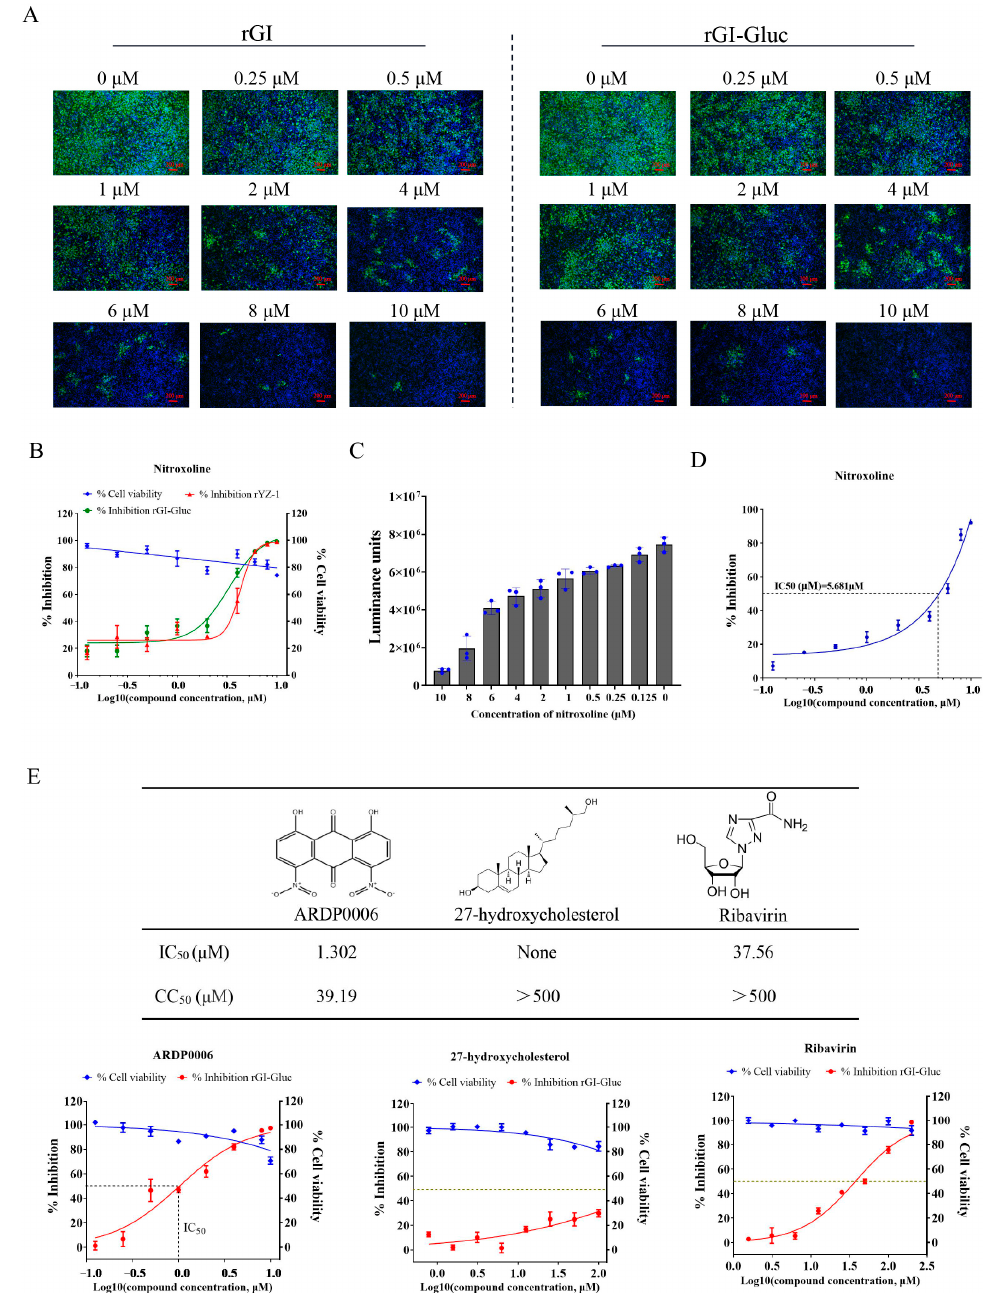
Figure 3. Application of Gluc-tagged GI JEV in the antiviral assay. ( A ) Antiviral effect of nitroxoline on rGI and rGI-Gluc infection. BHK-21 cells were respectively infected with rGI and rGI-Gluc at an MOI of 0.1 and simultaneously treated with serial two-fold dilutions of nitroxoline. At 36 hpi, the expression of NS3 protein in virus-infected cells was detected by IFA, and cell nuclei were stained with DAPI. ( B ) The antiviral effect of nitroxoline on the infection of rGI-Gluc and rGI in BHK-21 cells based on viral titer reduction. The cytotoxicity of nitroxoline on BHK cells at the indicated concentrations was measured by CCK-8 assay. The values represent the mean ± SD from three experiments. ( C , D ) The antiviral effect of nitroxoline on the infection of rGI-Gluc was determined by the reduction in the Gluc activities. The 50% inhibitory concentration (IC50) values were calculated by the Log (dose)-response curves. ( E ) Antiviral profiles of three compounds (ARDP0006, 27-hydroxycholesterol, and ribavirin) against rGI-Gluc in BHK-21